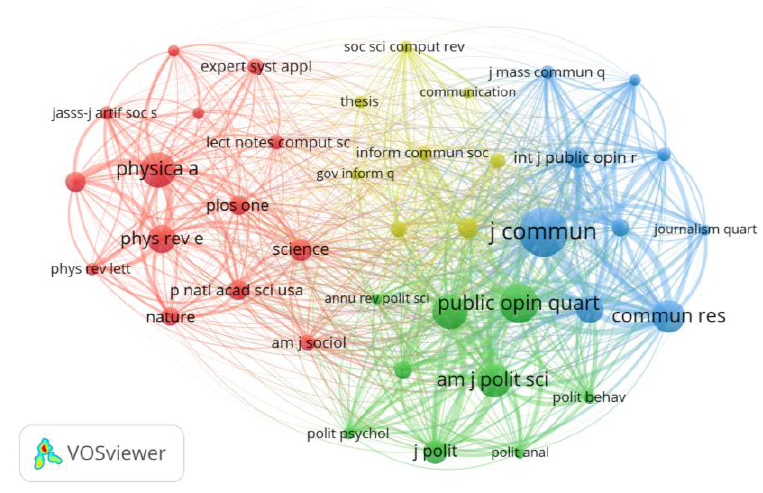
Figure 12. The journal co-citation network of NPO studies.